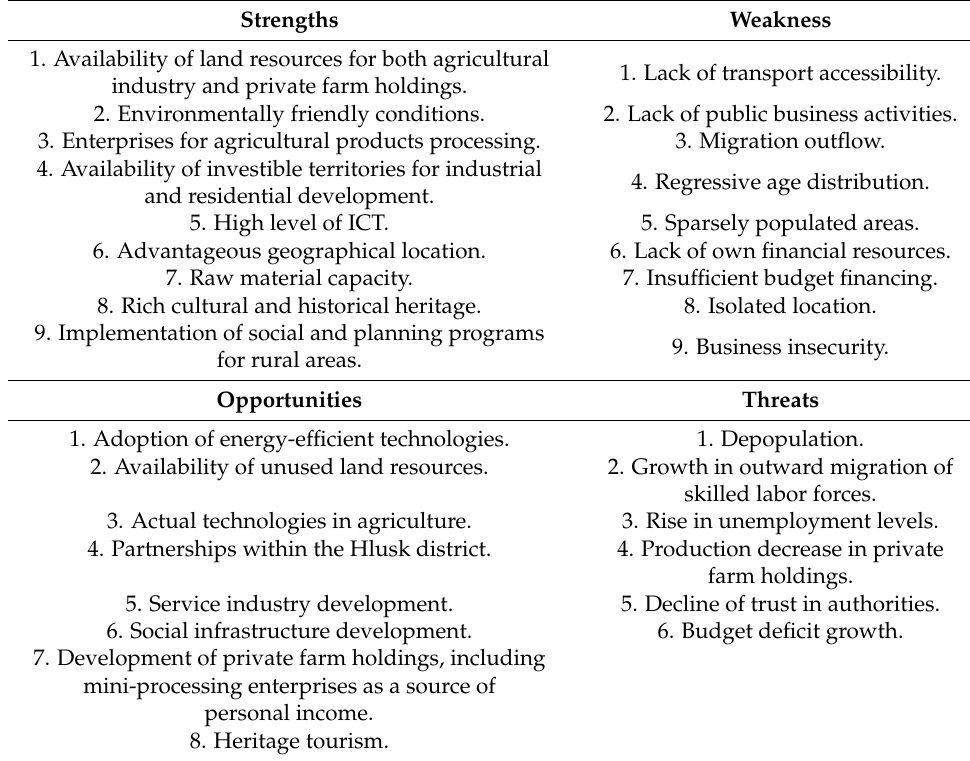
Table 1. SWOT Analysis of the Zavalocycy local